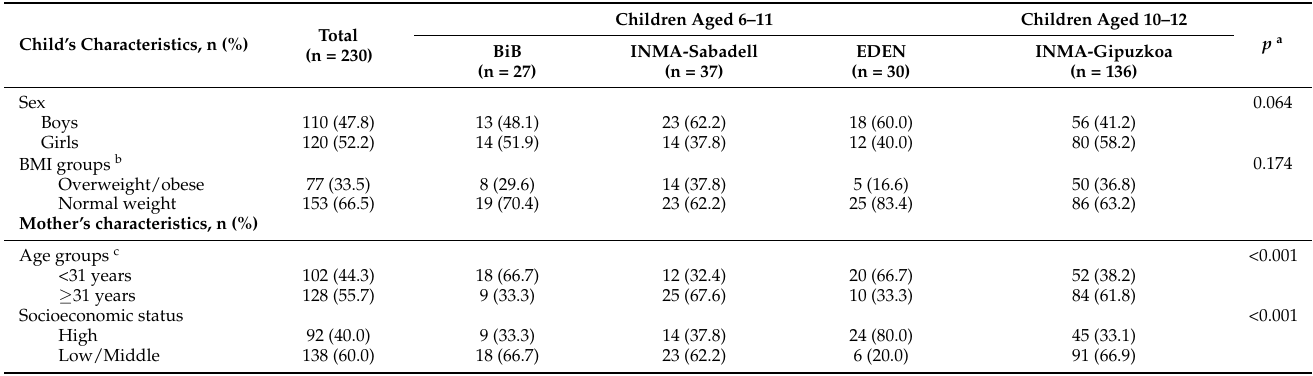
Table 1. Characteristics of mother-child pairs according to